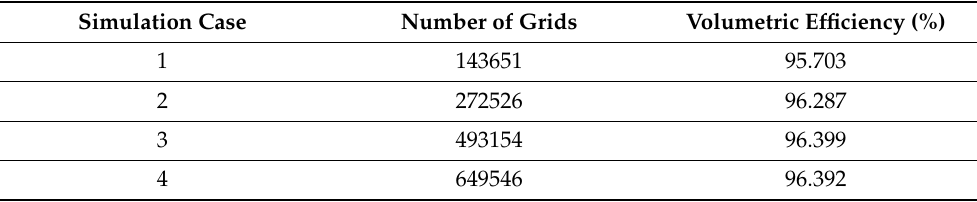
Table 2. Grid independence verification.